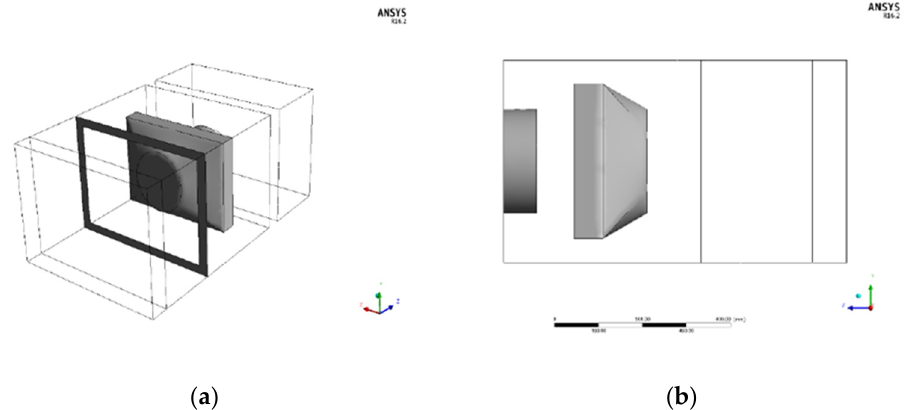
Figure 10. New design of the FCU inside the AHU: ( a ) view in perspective and ( b ) side view (right).